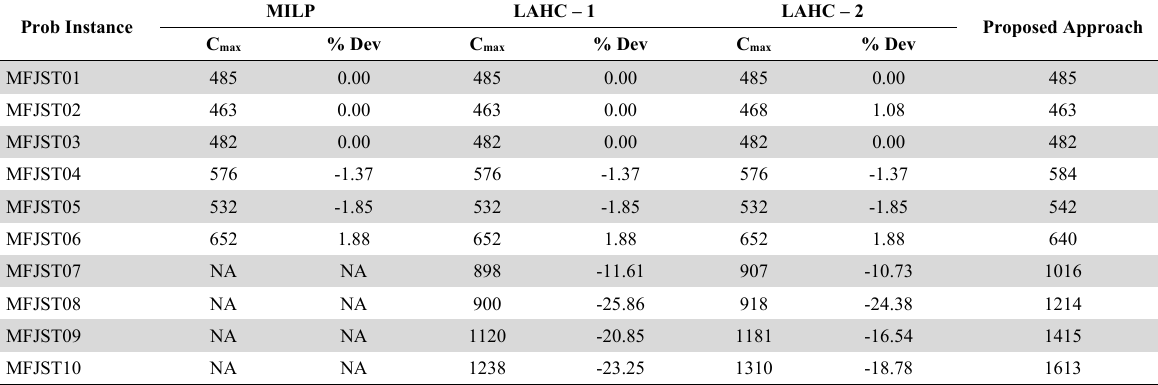
Comparison of Proposed Approach Results for Problem Set 3 (Medium Sized Problems) for C max minimisation Prob Instance